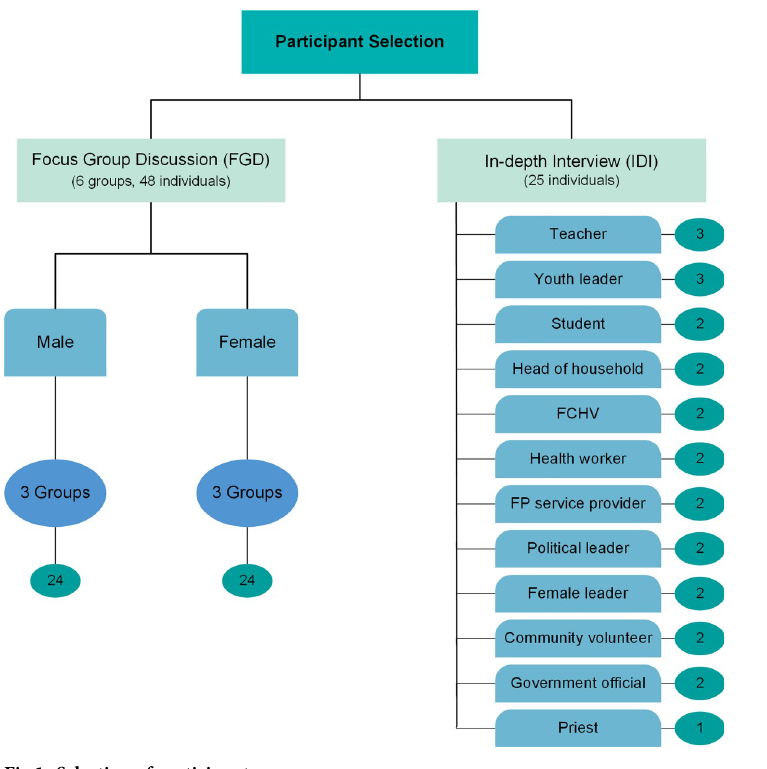
Fig 1. Selection of